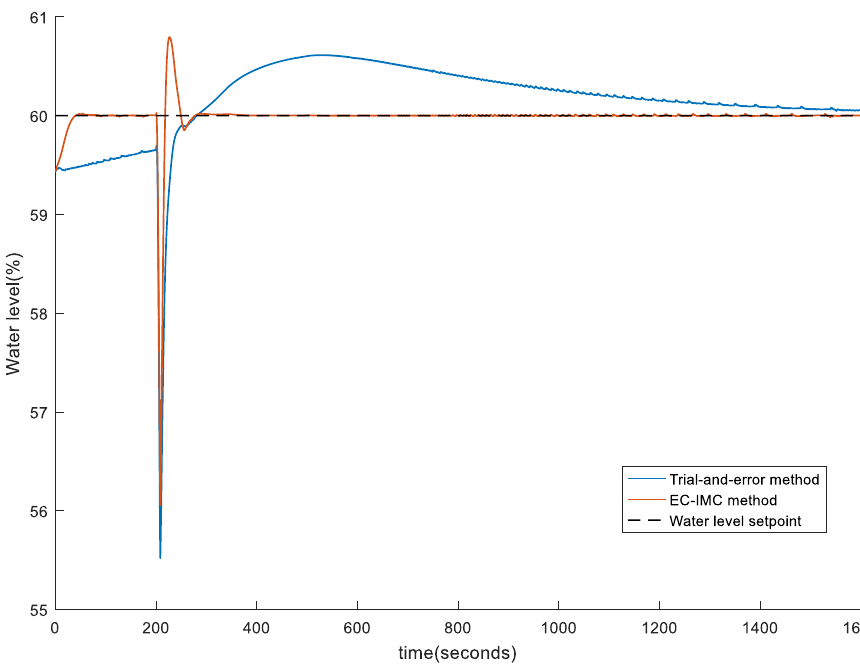
Figure 17. Water level response of power level step change from 75% to 65%.